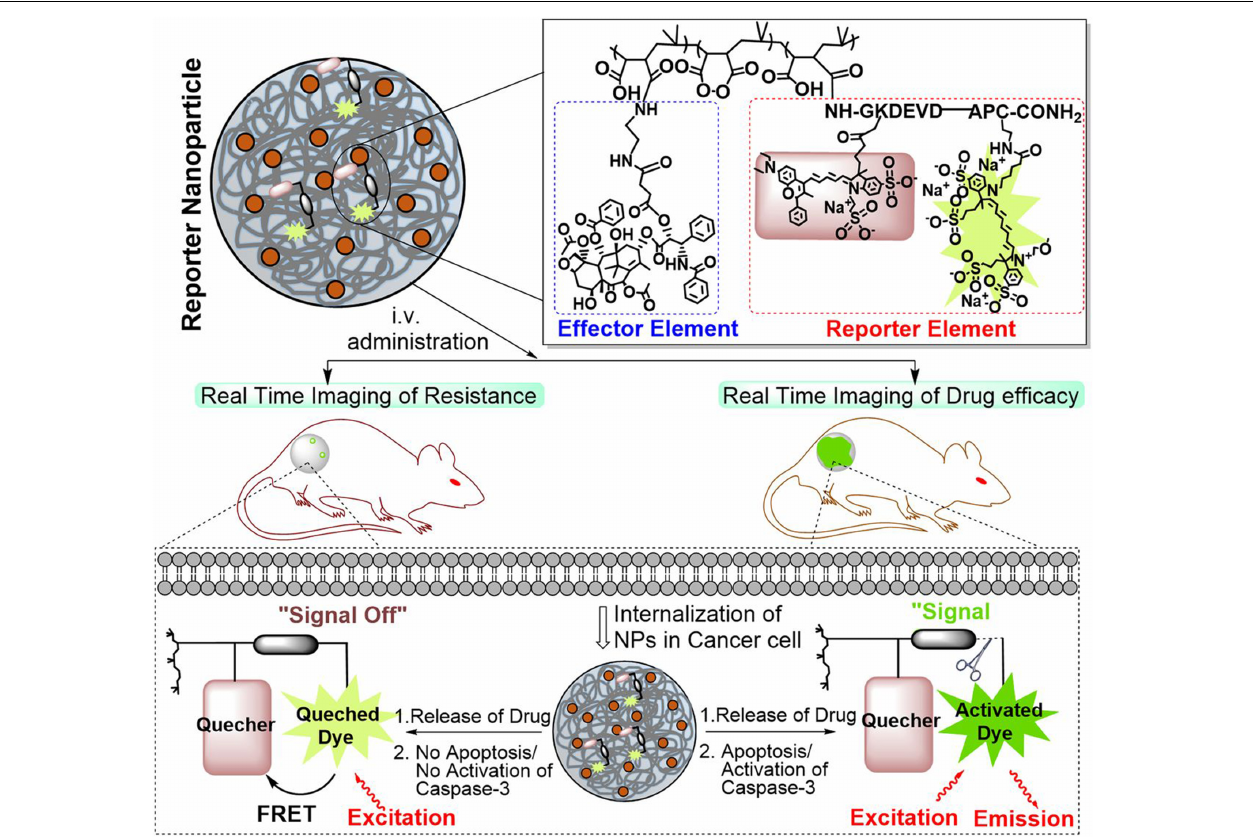
FIGURE 5 | Schematic illustration of the construct of a caspase-3 enzyme-responsive nanoparticle. The reporter nanoparticle comprises three components: a polymeric backbone, an esterase-cleavable prodrug synthesized from an anticancer drug [effector element (EE)], and an activatable reporter element (RE). At the optimal ratio of EE: RE, this stimuli-responsive polymer self-assembles into a nanoparticle. The reporter element is a caspase-3–cleavable sequence consisting of L -amino acids GKDEVDAPC-CONH2, to which we conjugated a FRET pair such that cleavage of the DEVD sequence results in removal of the quenching of the fluorescent signal. The effector element is conjugated to the polymeric backbone via an esterasecleavable bond, whereas the reporter element is conjugated via an amide bond with the Gly residue. In normal conditions, the fluorescent signal from the reporter element is in the off-state because the drug is intact inside the nanoparticle. In a drug-sensitive cell (lower right of the schematic), the released drug initiates apoptosis via the activation of the caspase-3 enzyme, which then cleaves the DEVD peptide, unquenching the fluorescent signal (on the state). However, in a non-responder cell (lower left), the failure of the released drug to induce apoptosis means the reporter element remains in the off state. Reprinted from Ashish Kulkarni, Poornima Rao, Siva Natarajan, et al. Reporter nanoparticle monitors its anticancer efficacy in real-time. Proc Natl Acad Sci U S A. 2016;113(15): E2104–13. With permission from reference (Kulkarni A. et al., 2016). FRET, Förster resonance energy transfer; DEVD, Asp-Glu-Val-Asp.